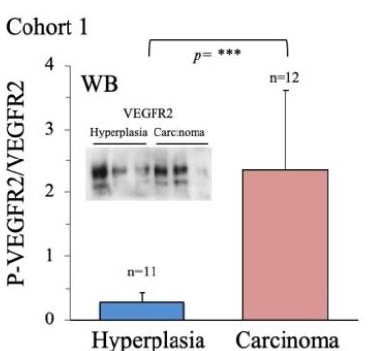
Figure A1. Higher activation of VEGFR2 in thyroid carcinoma than in hyperplasia. Activity of VEGFR2 was evaluated in thyroid tissue samples by western blotting using specific antibodies directed against the phosphorylated form of VEGFR2 (p-VEGFR2) and the VEGFR2 protein. The graph shows the p-VEGFR/VEGFR2 ratio. Data are mean ± standard deviation (SD). ***, p ≤ 0.005.